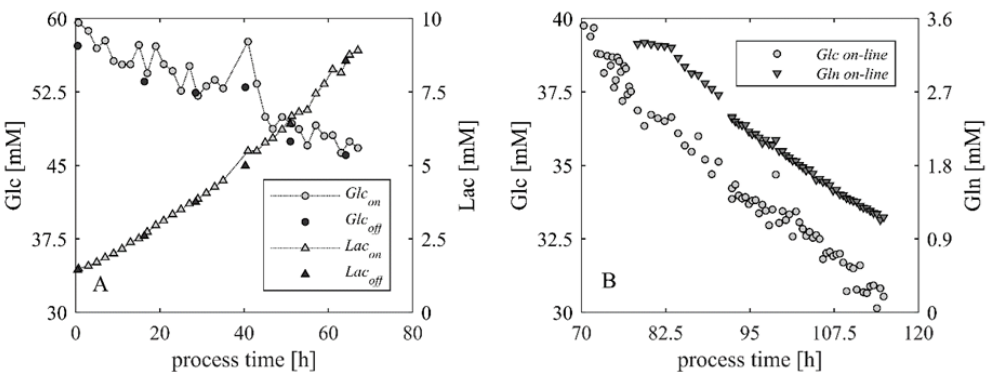
Figure 9. On-line monitoring of substrates and metabolite in a CHO batch process. Plot ( A ) shows the time course of glucose and lactate in the first 70 h of the process with a sampling interval of 2 h. Plot ( B ) shows glucose and glutamine reducing the sampling interval to the minimum of 30 min for 24 h (between 92 h and 116 h of process time). 24 h (between 92 h and 116 h of process